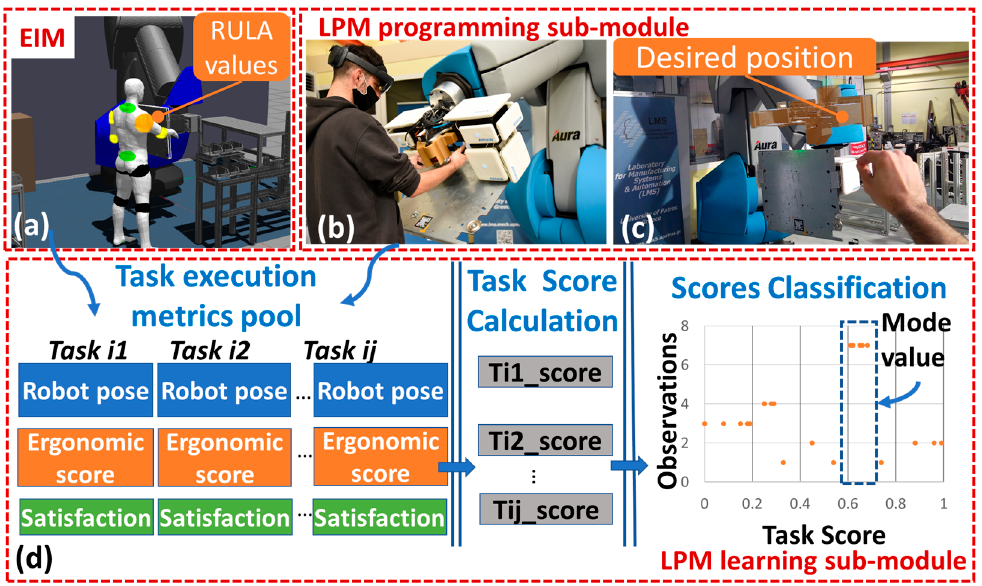
Figure 5. LPM and EIM functions.